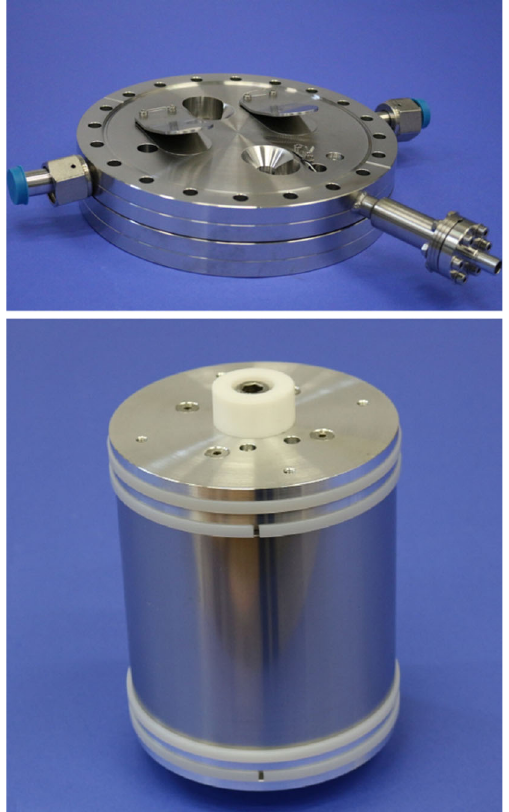
Fig. 8 Top: end flange containing gas-inlet and outlet, temperature